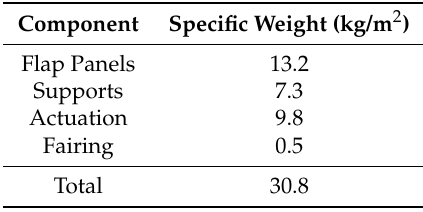
Table 3. Specific weight breakdown for single-slotted flap with link/track end support